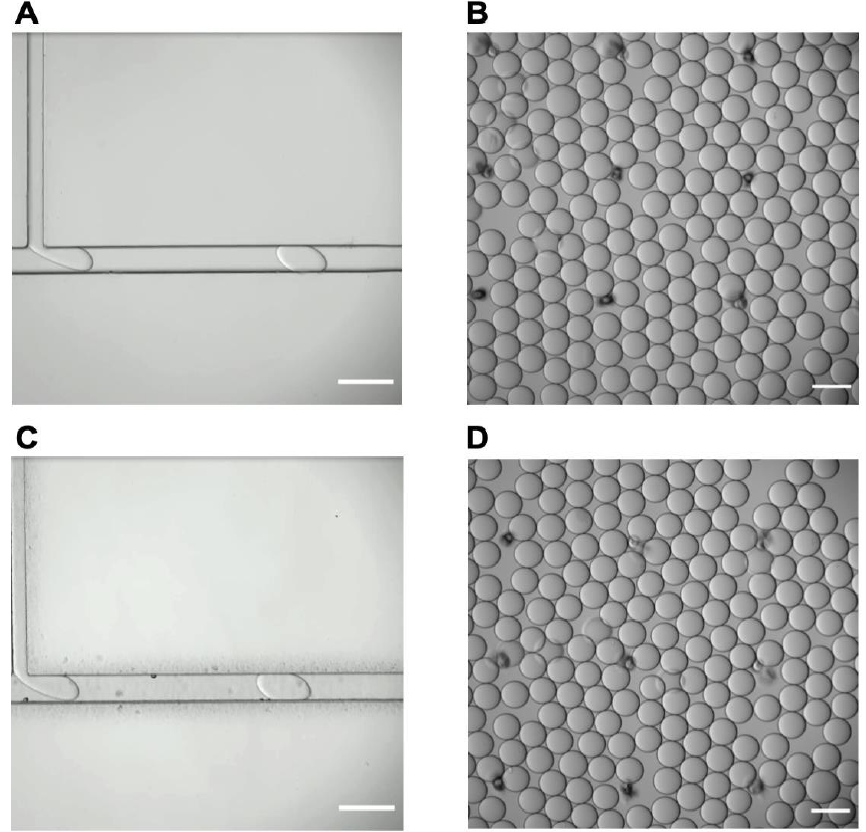
Figure 4. Droplet formation. ( A ) DUV Light System derived T-Junction microfluidic device at a 5:1 oil to water flow rate ratio with ( B ) derived droplets. ( C ) ABM 3000HR Mask Aligner derived T-Junction microfluidic device at a 5:1 oil to water flow rate ratio ( D ) with derived droplets. (Scale bar = 150 μm).